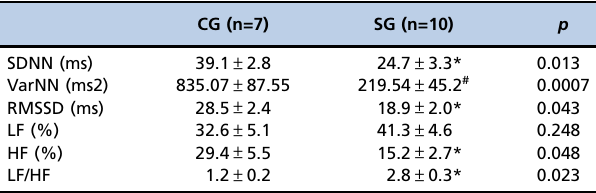
Table 2 - Heart rate variability in the time and frequency